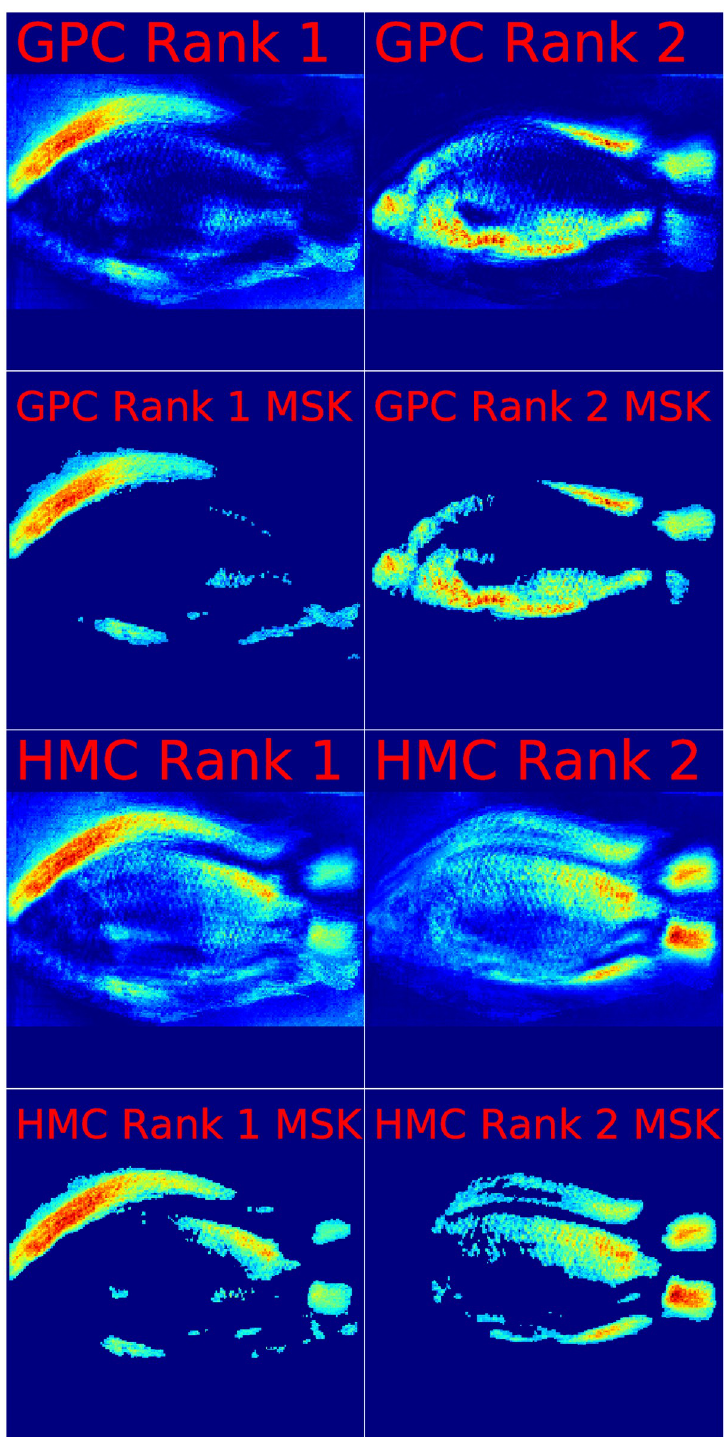
Fig 11. ARD level based visualizations of GP-LVM features in image space. This figure illustrates Nile tilapia body regions which are indicative for sample origin. Regional importance is visualized as color transition with blue indicating little importance, yellow indicating intermediate importance and red indicating high importance. Importance of image regions combines the GP-LVM variation maps in Fig 7 with the ARD level based ranks which obtain by classifying the lake of origin from 14 selected GP-LVM dimensions with Bayes inferred GPC